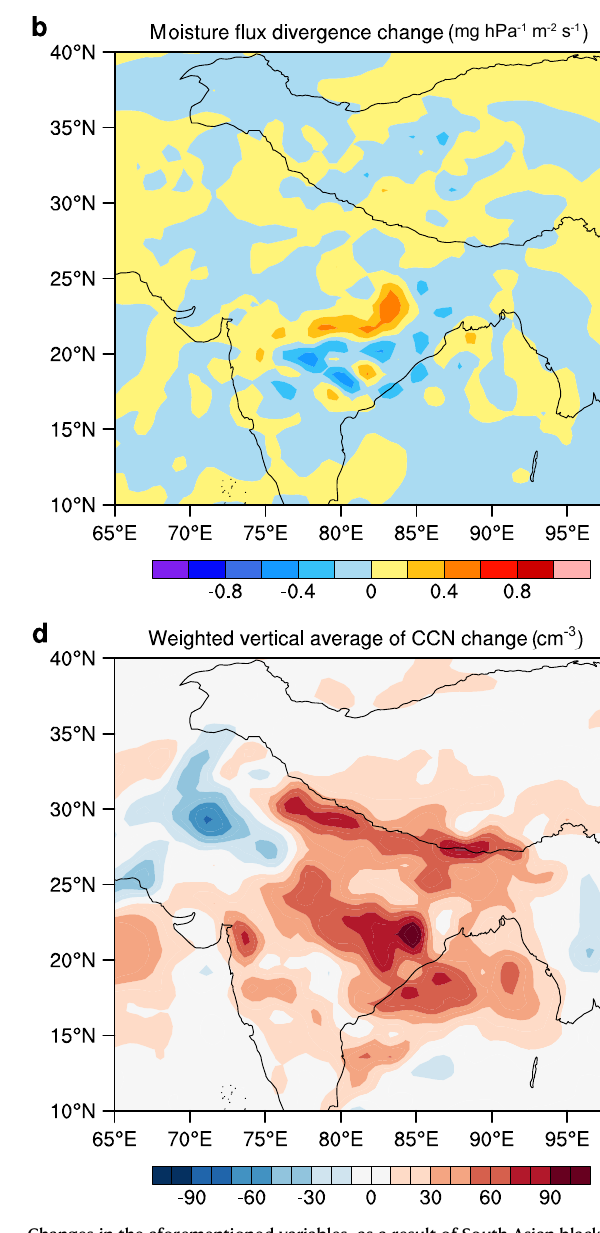
Fig. 4 | Summer meteorological conditions change simulations using the Weather Research and Forecasting model with Chemistry (WRF-Chem). For the period 2007 – 2016: a South Asian black carbon triggered average summer moisture fl ux change. b Averaged moisture divergence change at 500